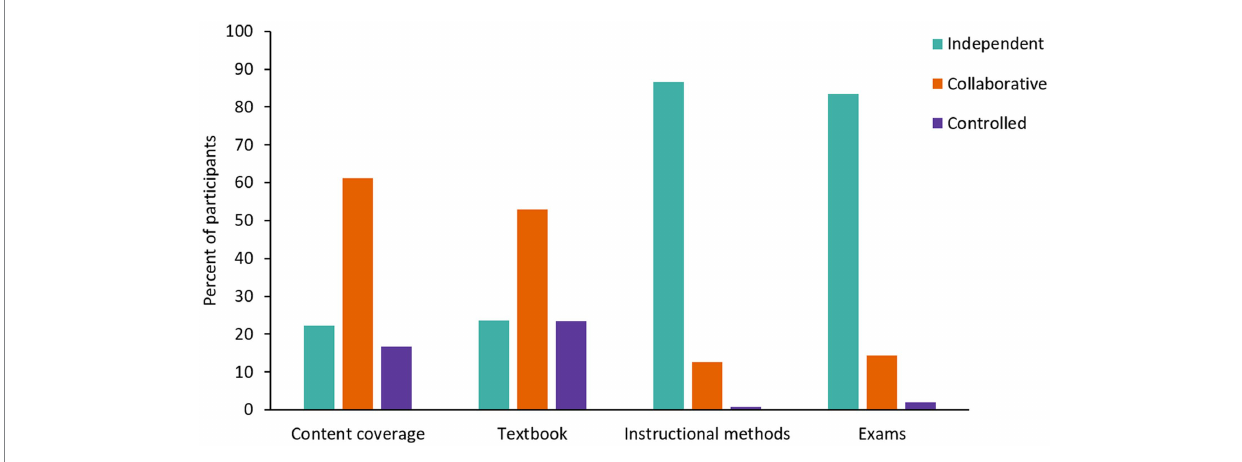
FIGURE 2 Decision-making authority among instructors of undergraduate chemistry, mathematics, and physics introductory courses in the United States ( n = 3,641). Decision-making was determined based on instructor responses to survey items for the four course components: Independent = myself (coded 1), Collaborative = myself and one or more others (coded 2), and Controlled = one or more others (coded 3).